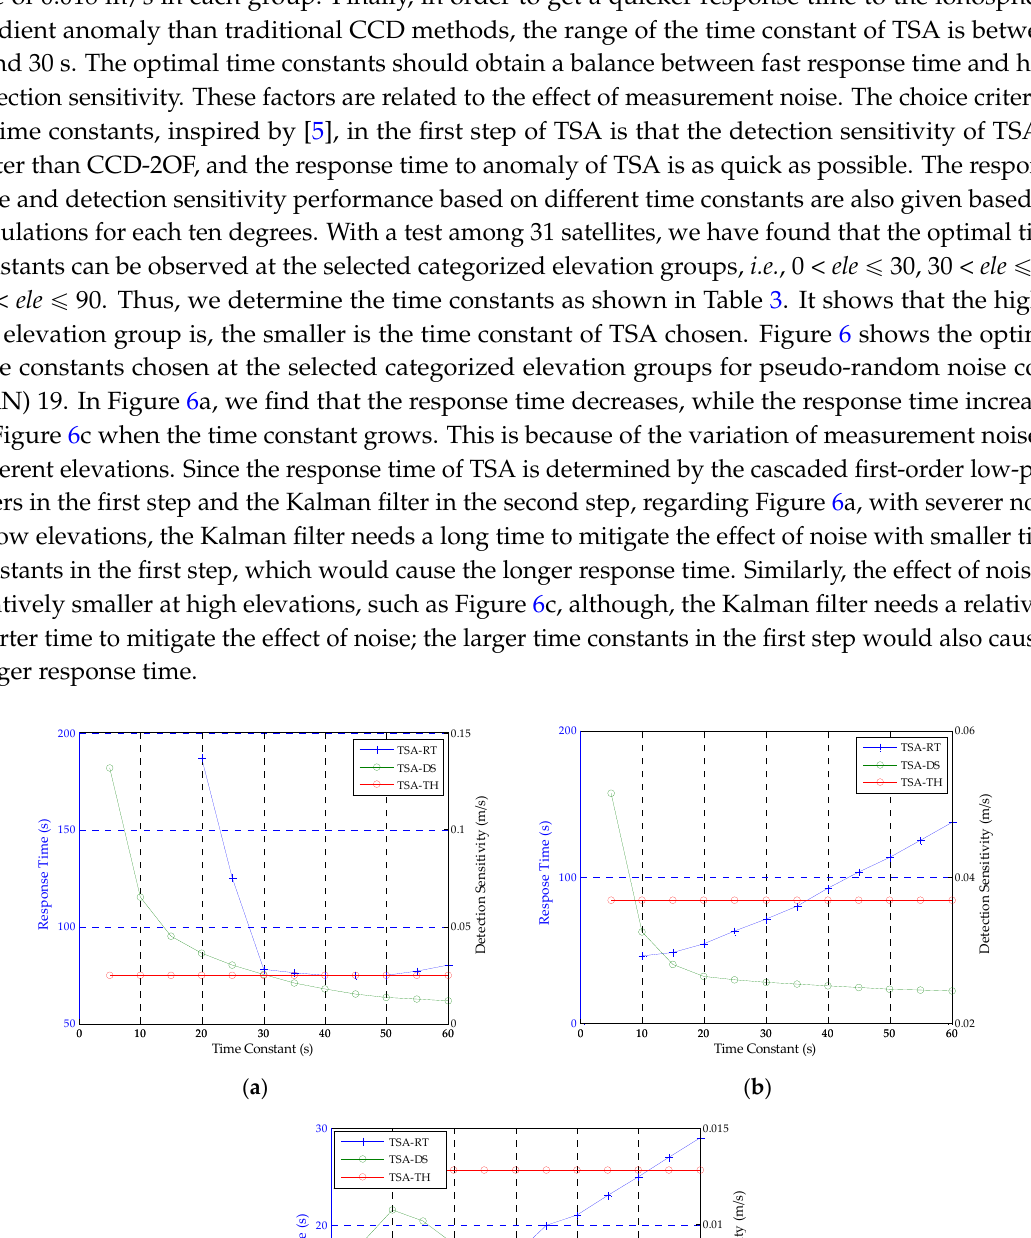
After the time constant is chosen in each elevation group, the detection thresholds in terms of satellite elevations at intervals of 10° are computed using the mean and standard deviation of the TSA in normal conditions. In addition, K ffd is set to 5.73 again, and the inflation factor f is chosen from Figure 7a. Figure 7b shows that test statistics and the determined thresholds with respect to the elevation angle at each bin; we interpolate the thresholds at each bin with the 7th polynomial fit as the red circle. Figure 8 shows that the mean and the standard deviation distribution comparing between TSA and the traditional CCD methods with the corresponding time constant. The results show that the standard deviation of TSA is better than CCD-1OF and CCD-2OF under normal conditions. Because the standard deviation is much larger in the first group, we just show the other groups in Figure 8. The average estimation accuracy of TSA compared to the CCD-1OF and CCD-2OF improves 41.3% and 31.3%, respectively. From Figure 8, it is shown that the standard deviation decreases with the increasing of elevation angles for each CCD method.